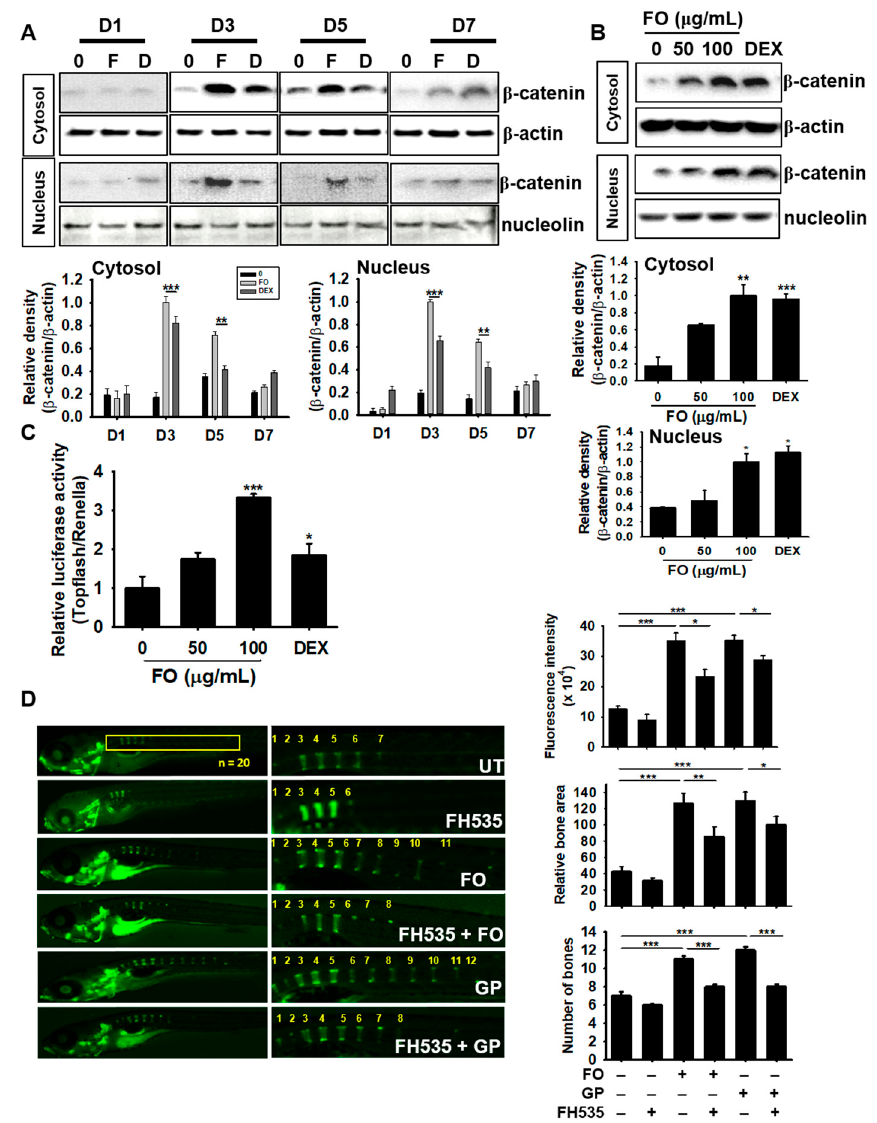
Figure 7. FO enhances osteogenesis via crosstalk with the Wnt/ β -catenin pathway. MC3T3-E1 cells were treated with 100 μ g/mL of FO and 100 nM DEX for 7 days. ( A ) The cells were harvested at day 1 (D1), day 3 (D3), day 5 (D5), and day 7 (D7). Next, western blot analysis was performed to quantify β -catenin expression. ( B ) The cells were treated with 50 μ g/mL and 100 μ g/mL of FO or 100 nM DEX for 3 days. Total protein was extracted to quantify β -catenin expression in the cytosol and nucleus. ( C ) To evaluate the effect of β -catenin/TCF signaling, TOPFlash activity was determined. ( D ) Zebrafish larvae (3 dpf; n = 20) were pretreated with FH535 for 24 h and then treated with 100 μ g/mL of FO or 100 nM DEX. The larvae were stained with calcein to observe vertebrae formation and mineralization 10 dpf. Relative calcein fluorescence intensity and total bone area were quantified using the Image J software and the number of vertebrae was manually counted. Significant differences among the groups were determined using the one-way ANOVA followed by Bonferroni correction. All data are presented as mean ± SEM (*** p < 0.001, ** p < 0.01, and * p < 0.05 versus untreated group). FO; fermented extract of C. gigas , DEX; dexamethasone, GP; β -glycerophosphate, dpf; days post fertilization, and UT; untreated group.